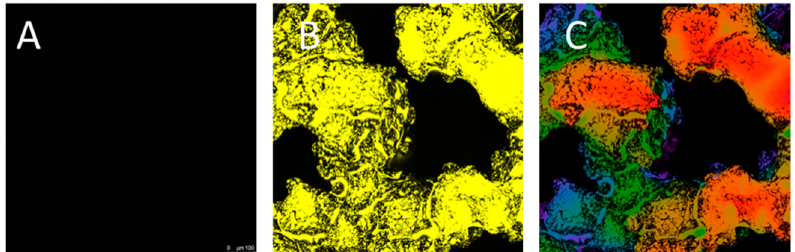
Figure 3. Confocal micrographs of DPBA (2-aminoethyl diphenylborinate) staining of 3D implants ( n = 2). A : Control uncoated 3D implant. B: Quercitrin-coated 3D implants. C: Image showing a depth projection micrograph of a Quercitrin-coated implant, images are 2D reconstructions of sections acquired repeatedly in sequential steps along the z -axis. The color code corresponds to the z -axis depth of DPBA fluorescence, coded from blue at 0 µm and pink at 500 µm depth.